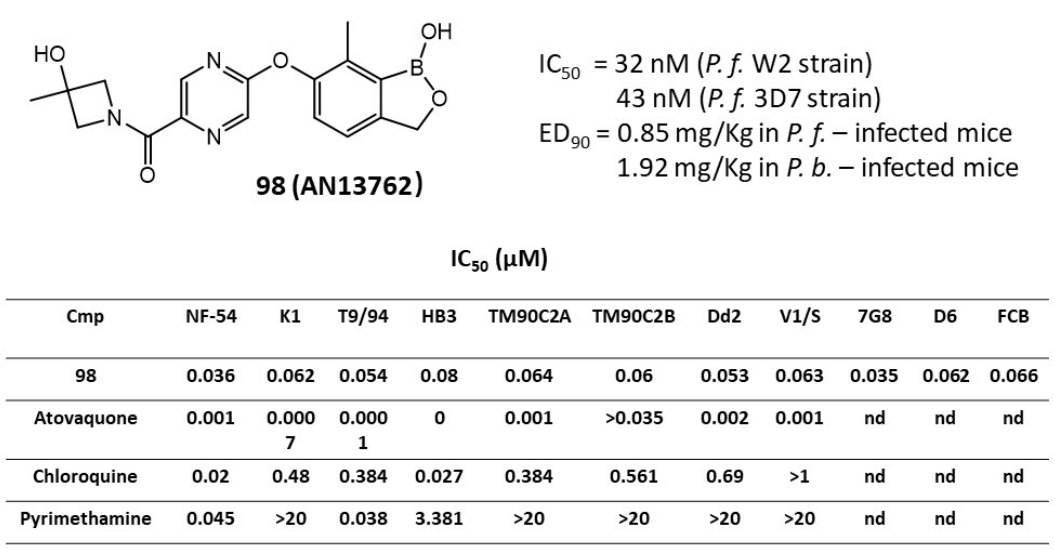
50 ) (Adapted from